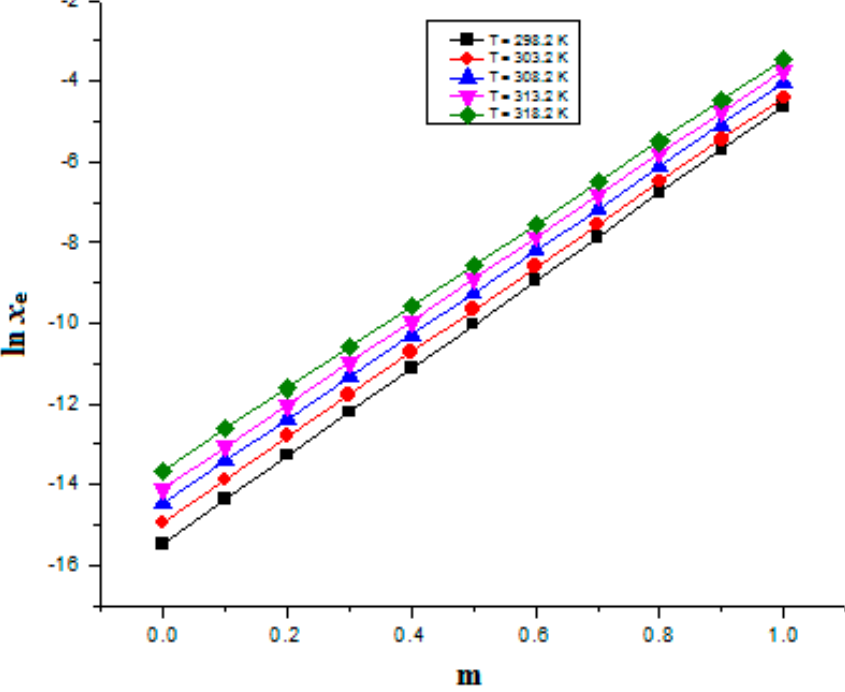
Figure 4. Influence of PEG 400 mass fraction ( m ) on FXT solubility values at 298.2-318.2